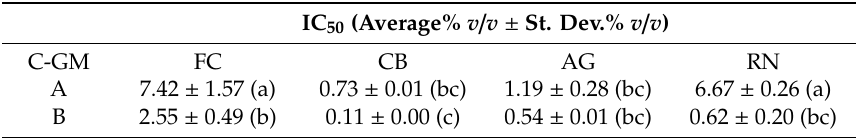
Table 4. IC 50 values of four C-GMs from two di ff erent producers (A and